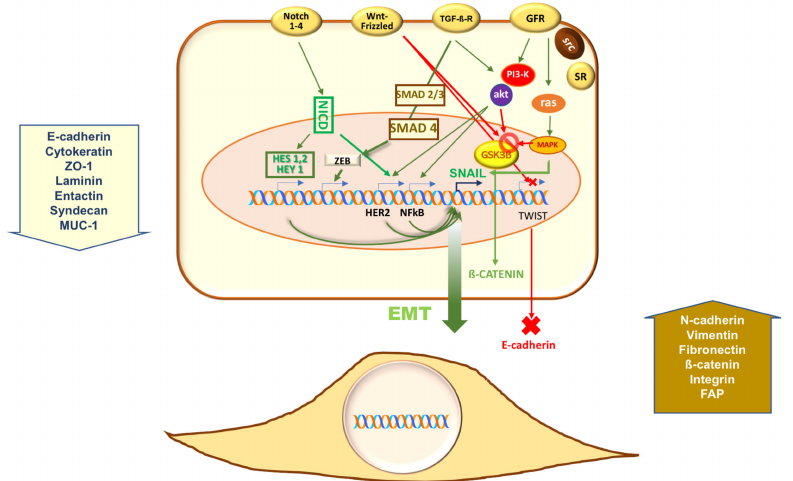
Figure 1. Pathways controlling the epithelial-mesenchymal transition (EMT) program in prostate cancer (PC). Growth factors (e.g., transforming growth factor β (TGF- β ), fibroblast growth factor (FGF), hepatocyte-derived growth factor (HGF), epidermal growth factor (EGF) and insulin-like growth factor 1 (IGF-1) released by the tumor microenvironment activate their cognate receptors (GFR, growth factor receptors; TGF β -R, TGF β receptor) thereby triggering downstream pathways. Through phosphoinositide-3 kinase (PI3-K), mitogen activated protein kinase (MAPK), small mother against decapentaplegic (Smad), glycogen synthase kinase-3 β (GSK3 β ), and nuclear factor kappa-light-chain enhancer of activated B cells (NF- κ B), growth factors increase the activity of transcriptional repressors of Zinc finger E-box-binding homeobox 2 (ZEB2), Twist, and Snail families. They, in turn, down-regulate E-cadherin and other epithelial cell markers, while inducing mesenchymal proteins [9–14,25,26,35]. As the ligand-bound steroid receptors (SRs) trigger rapid activation of these signaling circuits [27–29], it might be hypothesized that such activation also contributes to EMT in PC. Canonical wingless-INT (Wnt) is implied in EMT of PC through activation of GSK3 β . Stabilization and nuclear translocation of β -catenin then follow. This latter event leads to phosphorylation and nuclear translocation of snail family transcriptional repressors 1 (SNAI1). In such a way, the transcriptional activity of SNAI1 is enhanced [35]. Neurogenic locus notch homolog protein (Notch) 1–4 trans-membrane receptors can be activated by membrane-tethered ligands in mammals. Proteolytic cleavage of Notch receptors then follows, with the subsequent release of the Notch intracellular domain (NICD), which then enter nuclei to activate the transcription factors hairy and enhancer of split (HES) 1 and 2 as well as HES 1 related (HEY1). Through NF-kB, they control the expression of genes involved in EMT,